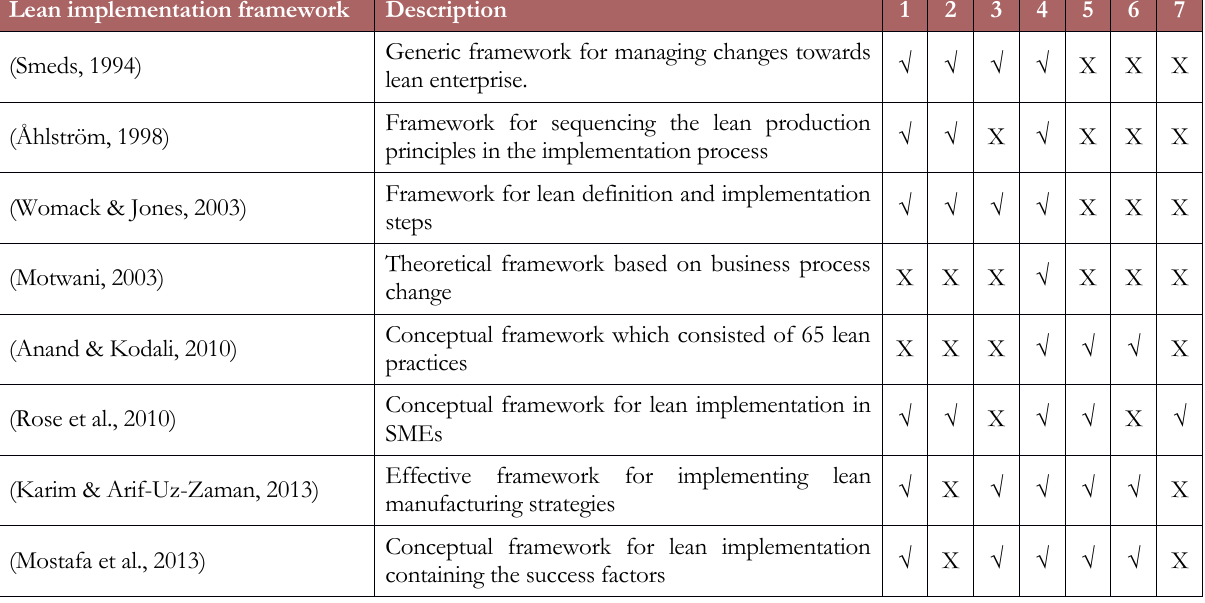
Table 1. Review of the main existing frameworks of lean implementation and its satisfaction of the characteristics of